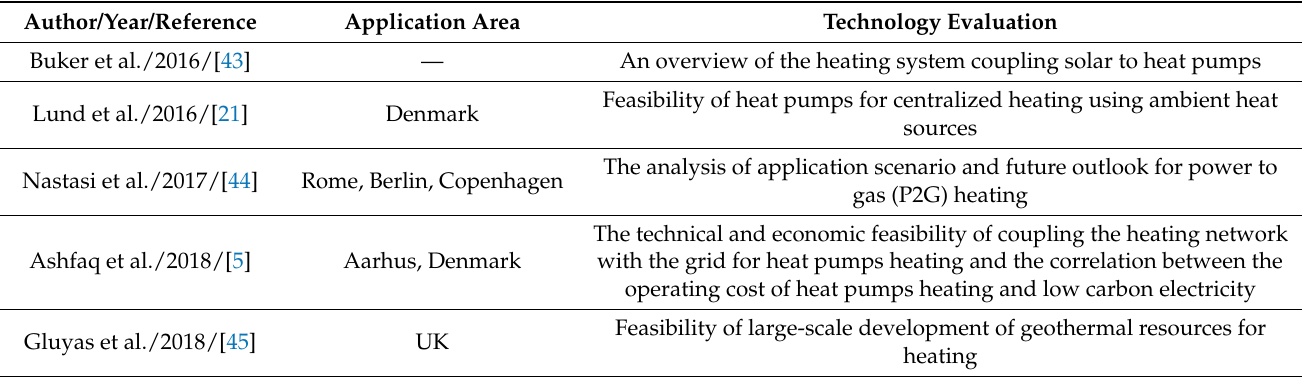
Table 2. Summary of clean heating literature in the last five